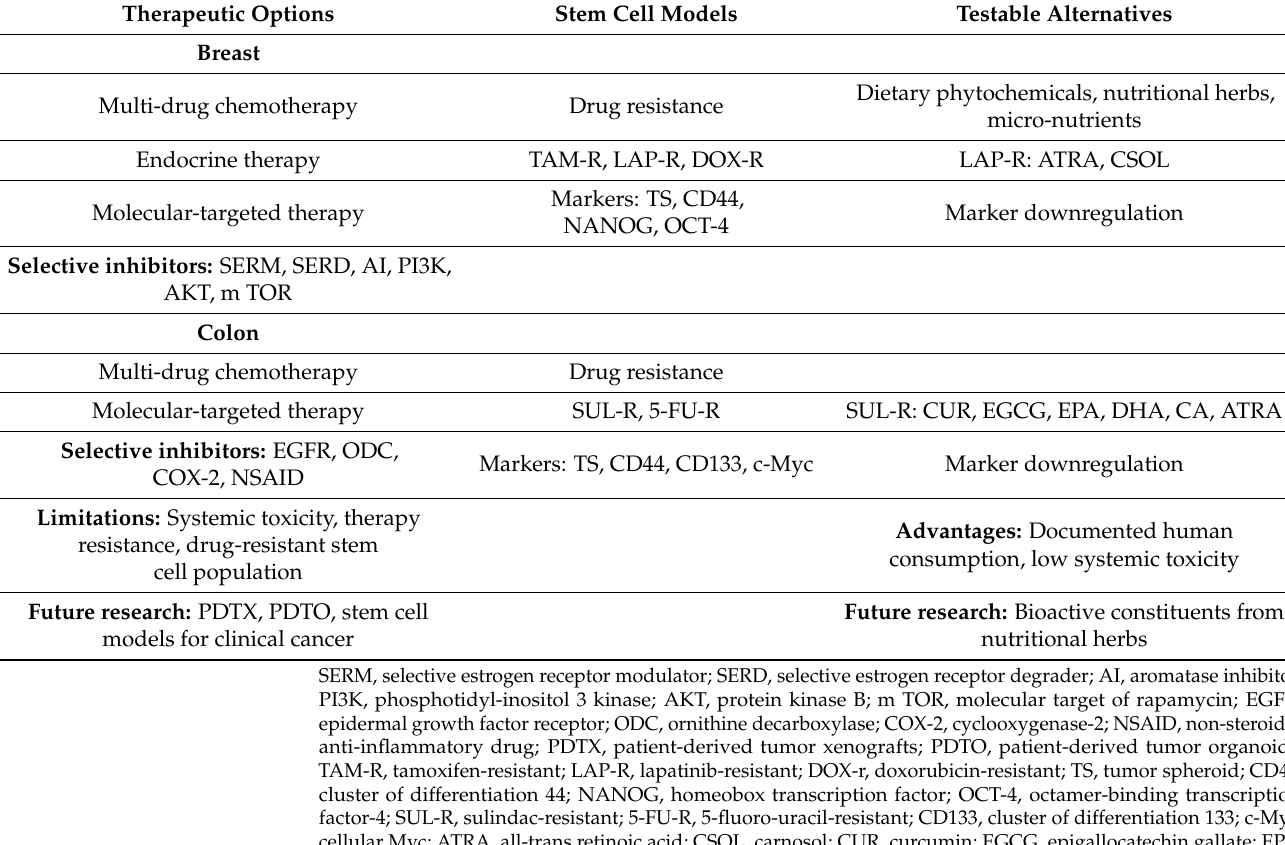
Table 5. Stem cell models: therapeutic